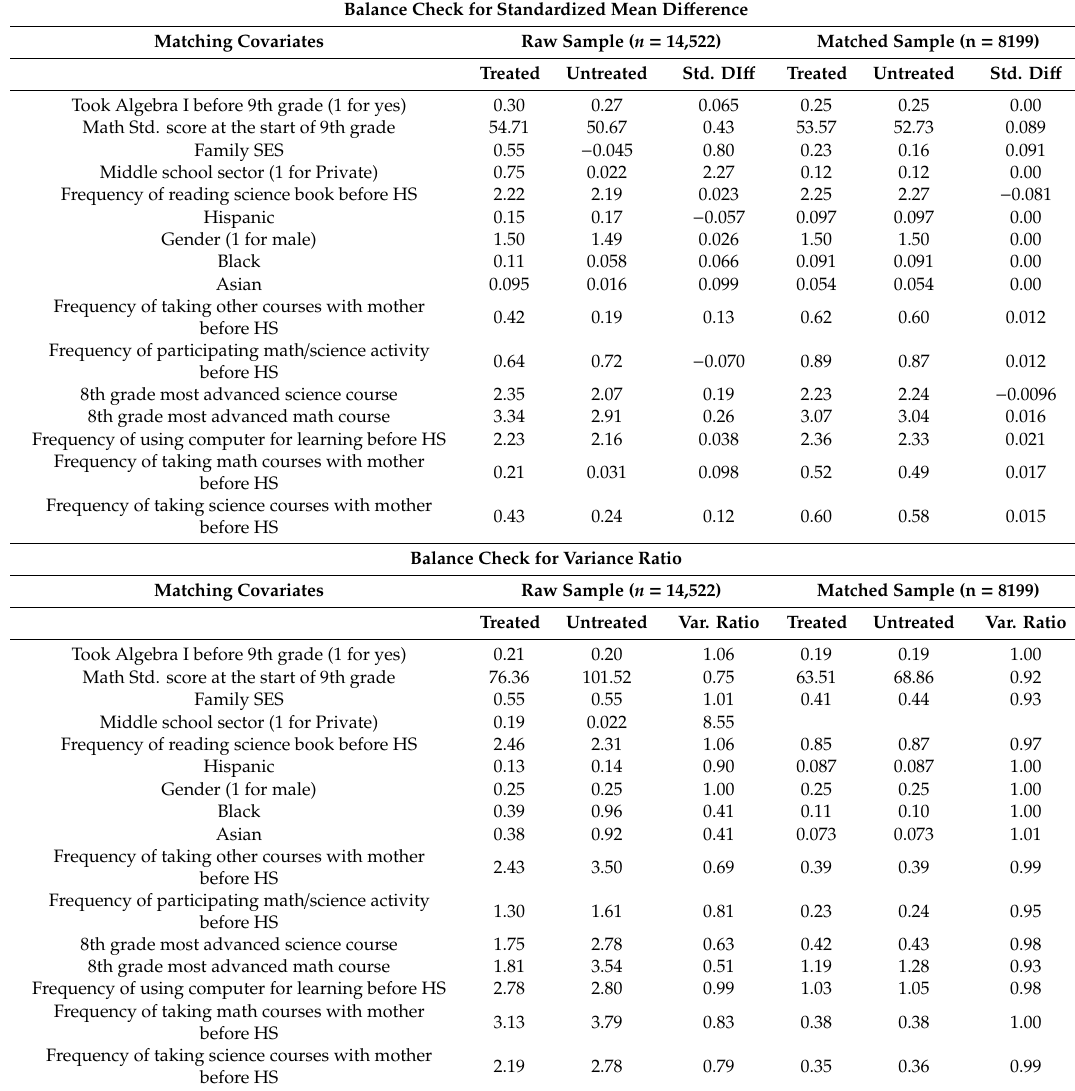
Table 8. Balance check for matching (standard di ff erence and variance